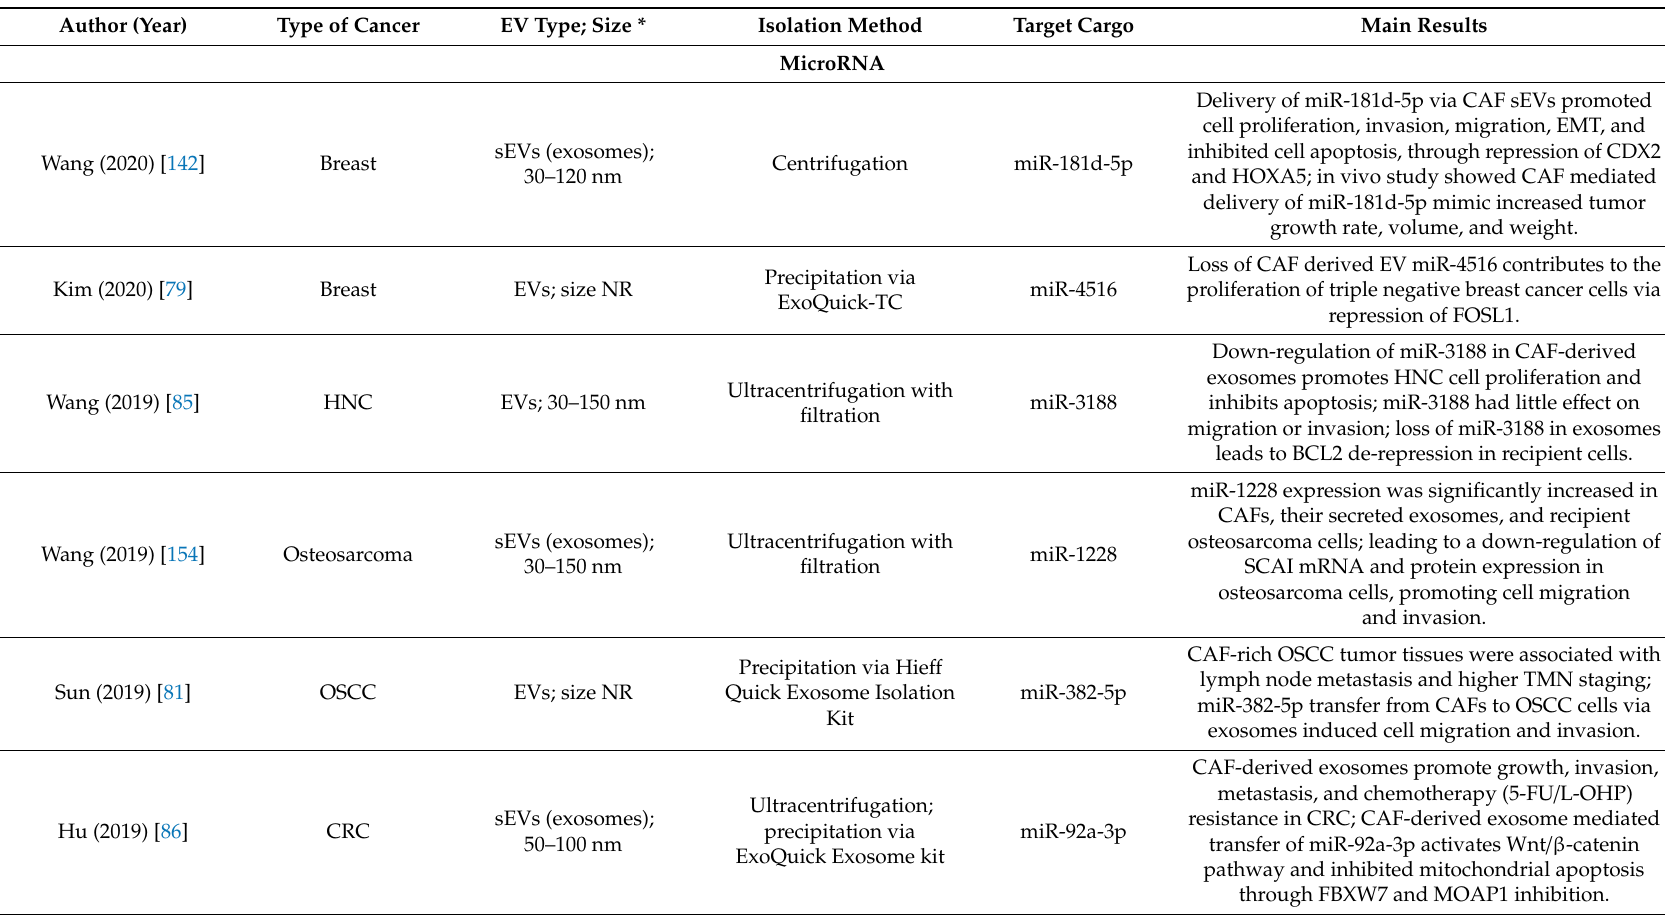
Table 2. Summary of e ff ects of cancer associated fibroblast-derived extracellular vesicles on cancer